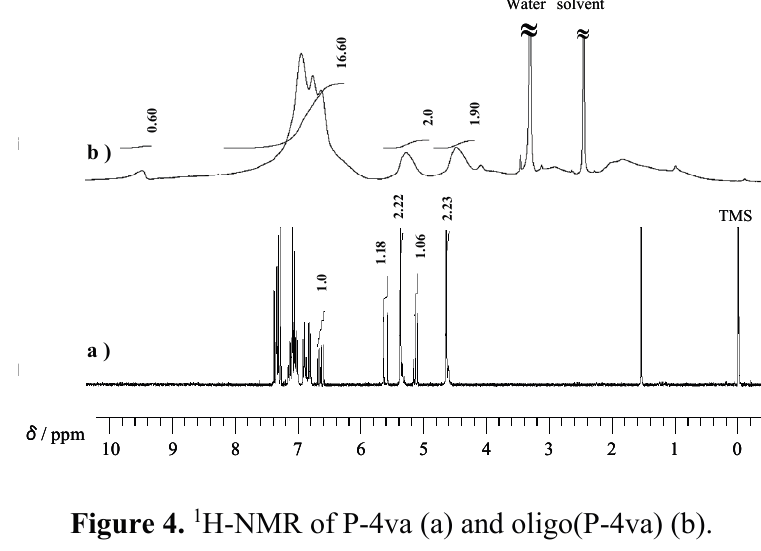
Figure 4. 1 H-NMR of P-4va (a) and oligo(P-4va) (b).